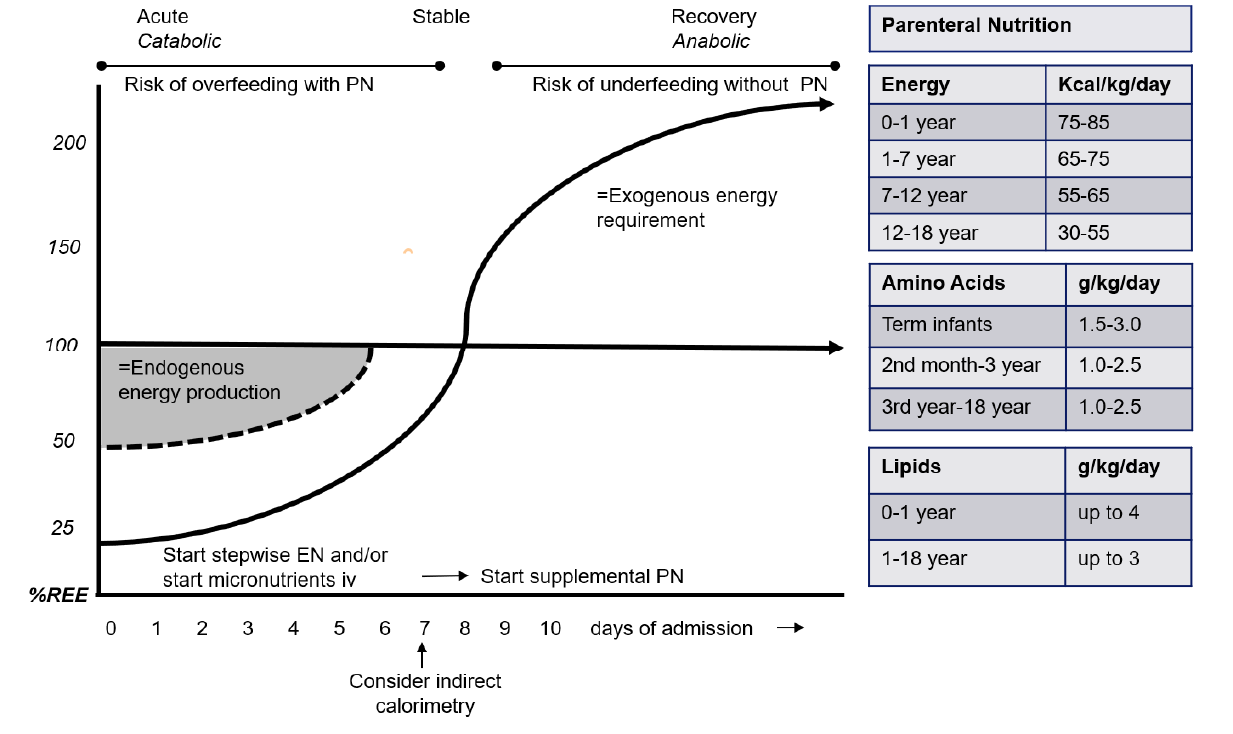
Figure 2. The dynamic energy needs during the different phases of critical illness, and the amount of parenteral nutrition (adapted from Ref. [36]). PN, parenteral nutrition; EN, enteral nutrition; REE, resting energy expenditure; iv, intravenous.